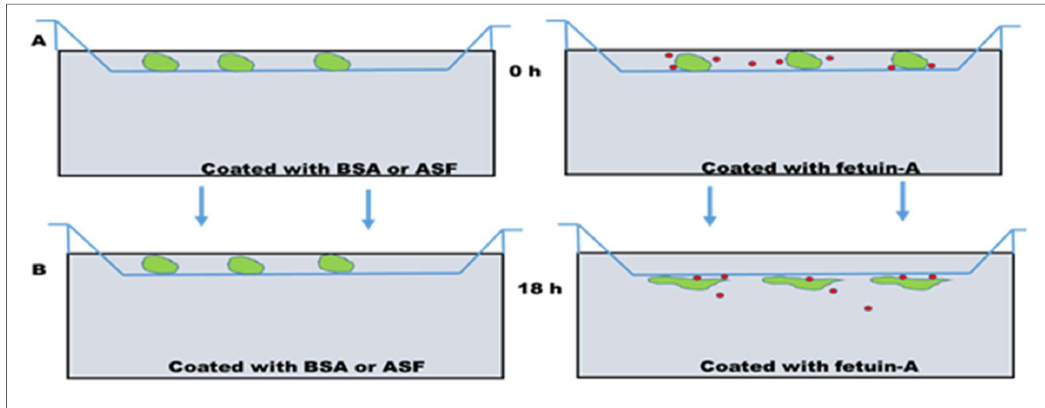
Figure 2. Model depicting how fetuin-A mediates motility and adhesion in tumor cells. ( A ), the lower wells of a Boyden Chamber plate can be coated with either bovine serum albumin (BSA) or asialofetuin-A (ASF) as a control, or with fetuin-A. Due to on and off rates, the coated fetuin-A can move by simple diffusion to the upper chambers containing the cells, enter the cells (green) on the top wells, and promote the secretion of exosomes (red dots) that mediate motility and adhesion of tumor cells to the underside of polycarbonate filters, over the 18 h period as shown. After 18 h ( B ), cells remaining on the upper wells are removed using cotton swabs, and the cells attached on the underside are fixed in 4% formalin, stained, and photographed.